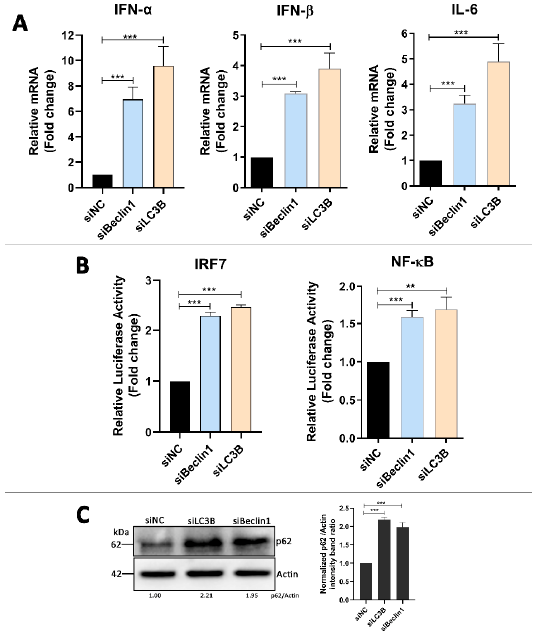
Figure 5. Effect of autophagy on innate immune responses in DTMUV-infected cells. ( A ) DEF cells were transfected with siNC, siBeclin 1, or siLC3B for 24 h prior to infection and then infected with DTMUV at an MOI of 1 for 36 hpi. qPCR analysis were performed for the mRNA levels of IFN- α , IFN- β , and IL-6. The mRNA levels of targeting genes to β -actin were normalized to control. ( B ) DEF cells were co-transfected with 0.1 μ g of NF- κ B-luc or IRF7-luc and with 0.01 μ g of the HSV-thymidine kinase promoter (pRL-TK) plasmid, along with siNC, siBeclin 1, or siLC3B for 24 h prior to infection. Cells were infected with DTMUV at an MOI of 1 for 36 hpi and then preformed for luciferase reporter assays. The luciferase activities of the targeting promoters were normalized to control. ( C ) Parallel samples from ( A ) were analyzed by Western blot and immunoblotted for LC3, DTMUV-E, and β -actin. The ratio of p62 to β -actin was normalized to control. Error bars: Mean ± SD of three independent experiments. Two-tailed Student’s t test; ** p < 0.01, *** p < 0.001.